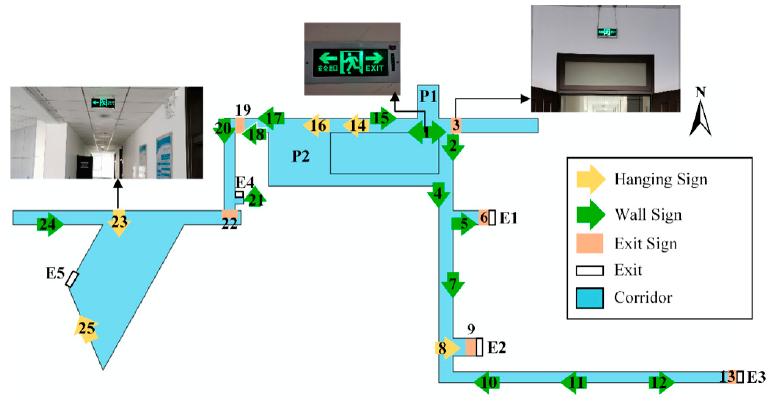
Figure 3. Layout of the evacuation guidance system.